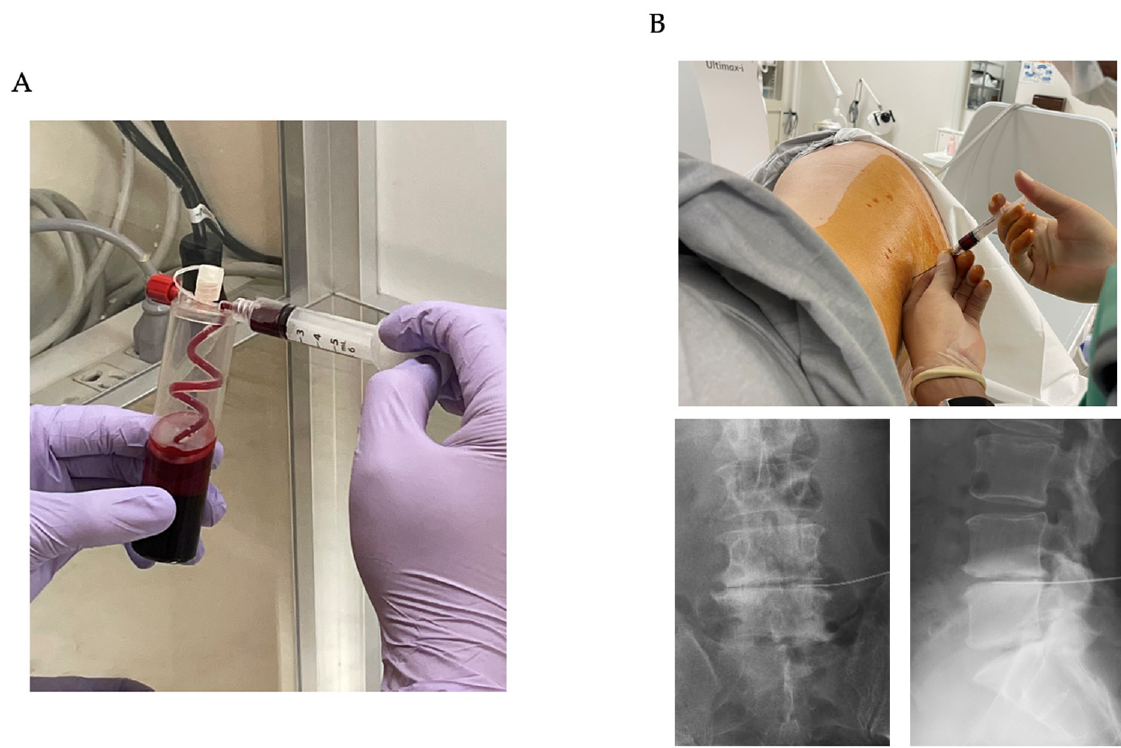
3 of 9 Table 2. LR-PRP components.